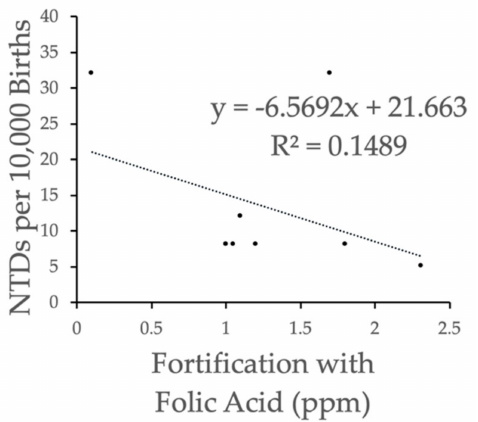
Figure 3. Prevalence of NTDs as a function of folic acid fortification levels in rice. The number of NTDs per 10,000 births was plotted (blue bars) versus country ( n = 17). Folic acid fortification levels of rice in ppm (orange bars) were superimposed on NTD prevalence. Linear regression analysis indicates a regression coe ffi cient (a) of −